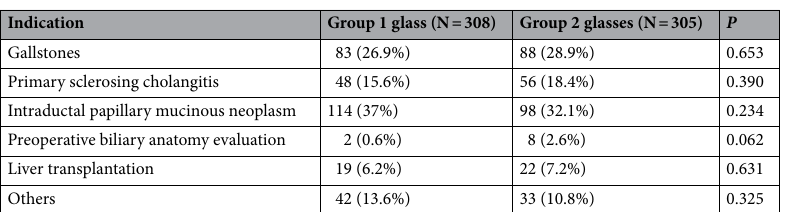
Table 2. Indications for MRCP in the two groups of